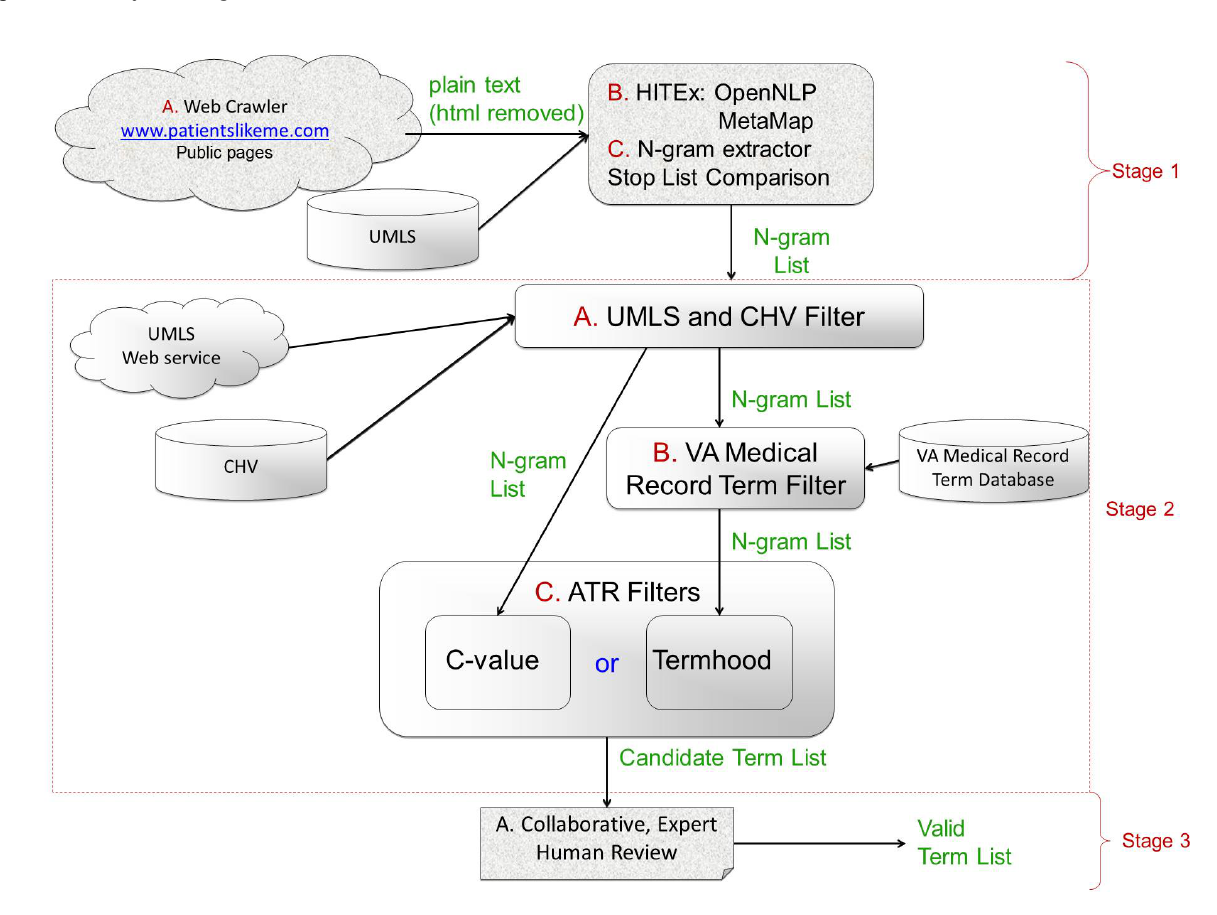
Figure 1. CAU System